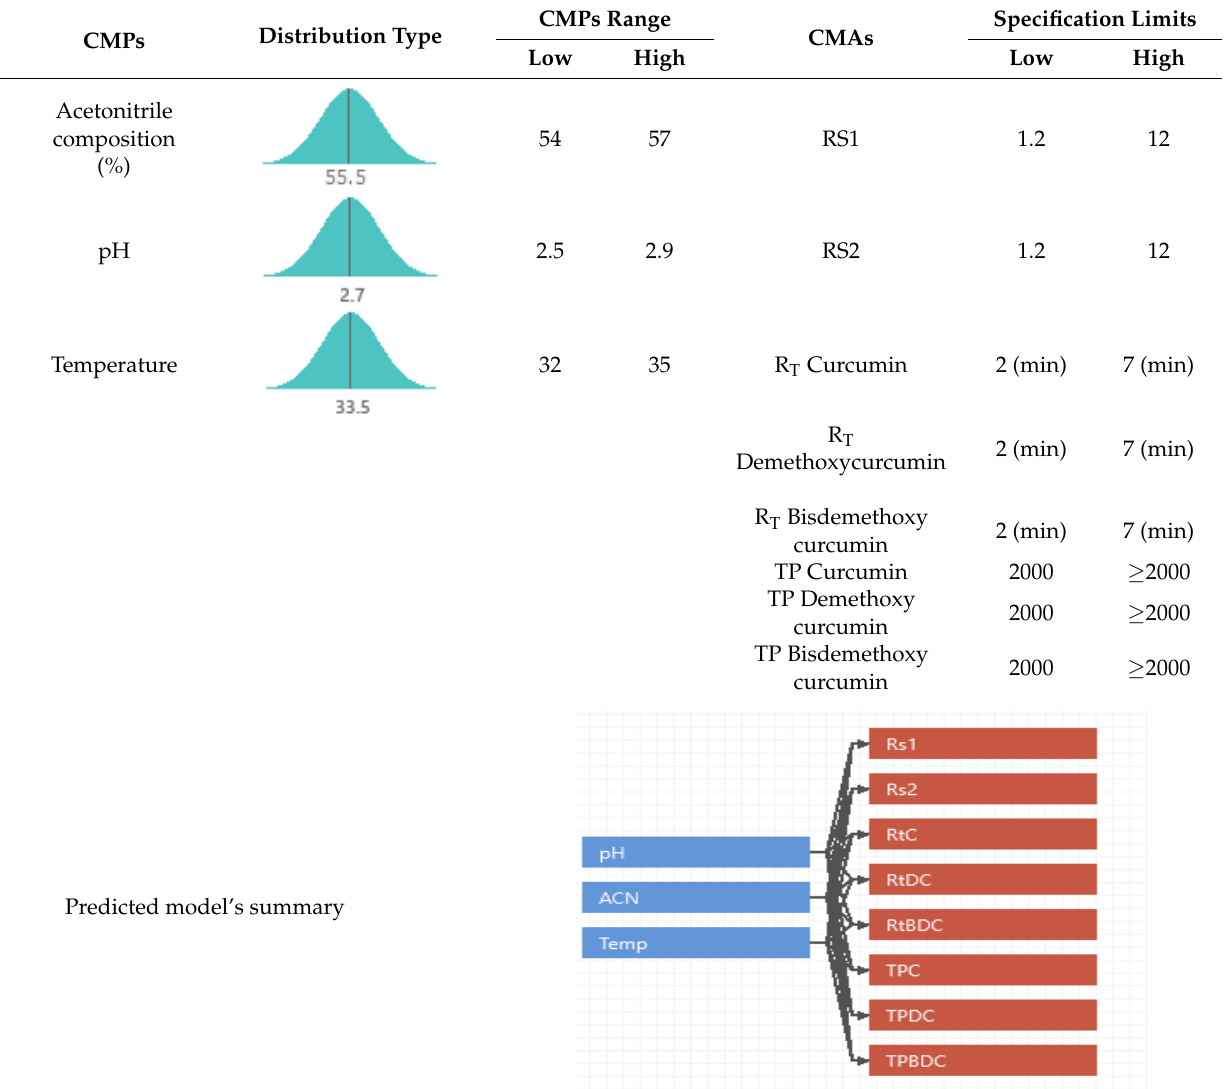
Table 4. CMPs values obtained by the Monte Carlo simulation method and the predicted separation model’s summary.